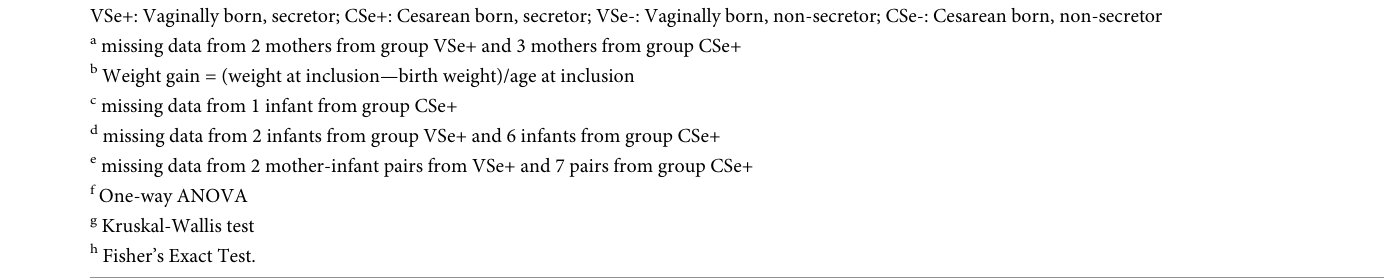
missing data from 1 infant from group CSe+ d missing data from 2 infants from group VSe+ and 6 infants from group CSe+ e missing data from 2 mother-infant pairs from VSe+ and 7 pairs from group CSe+ f One-way ANOVA g Kruskal-Wallis